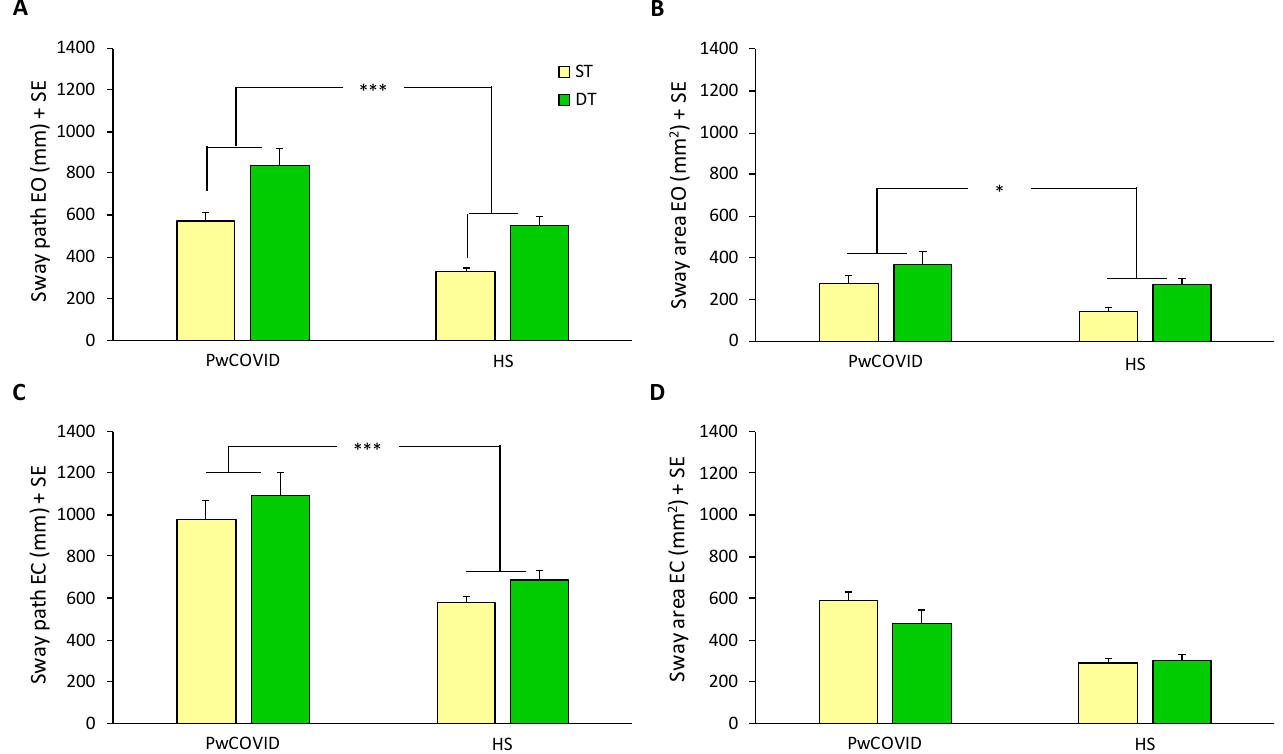
Figure 1. Sway path and sway area in EO and EC conditions, for PwCOVID and HS, with the ST vs. DT. PwCOVID and HS differed, as did the ST versus the DT, considering both groups together (not shown in the figure), except for the sway area with EC. Statistical analysis was performed with ANOVA, applying Bonferroni’s correction. *, p < 0.01; ***, p < 0.0005. Abbreviations: ST, single-task; DT, dual-task; PwCOVID, people with COVID-19; HS, healthy subjects; EO, eyes open; EC, eyes closed; SE, standard error.